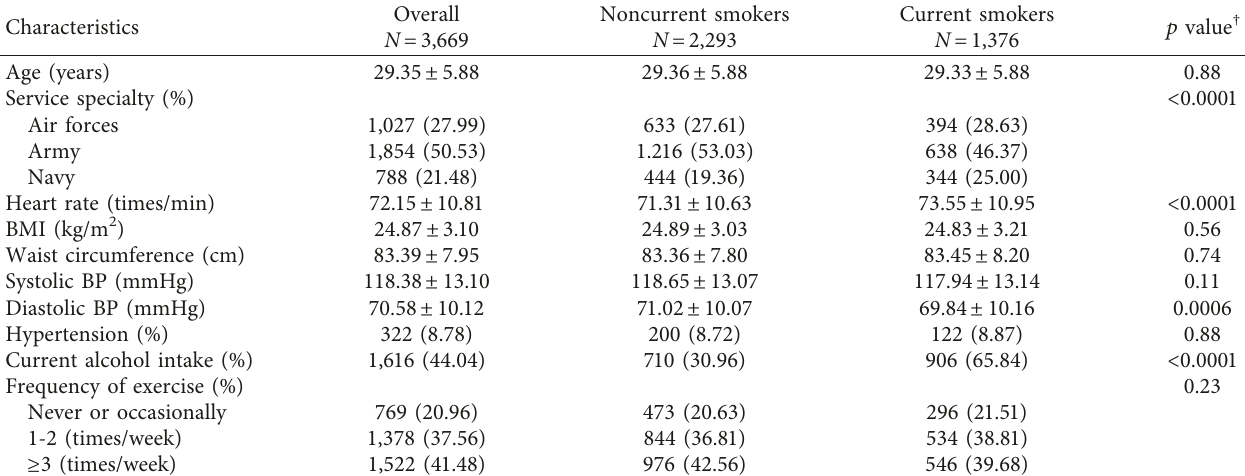
Table 1: Baseline characteristics and exercise performances of noncurrent smokers and current smokers. Characteristics